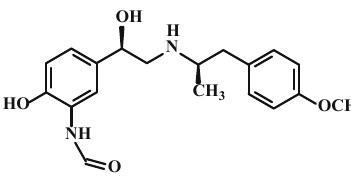
Figure 6: Structure of arformoterol.